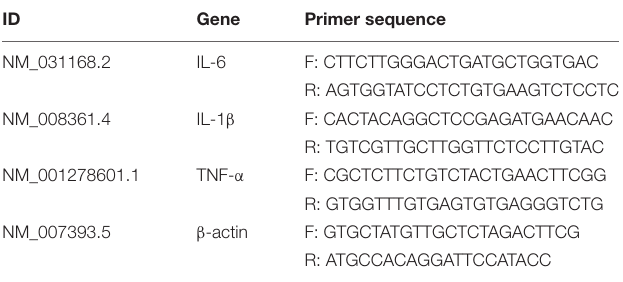
TABLE 3 | The information of primer sequence